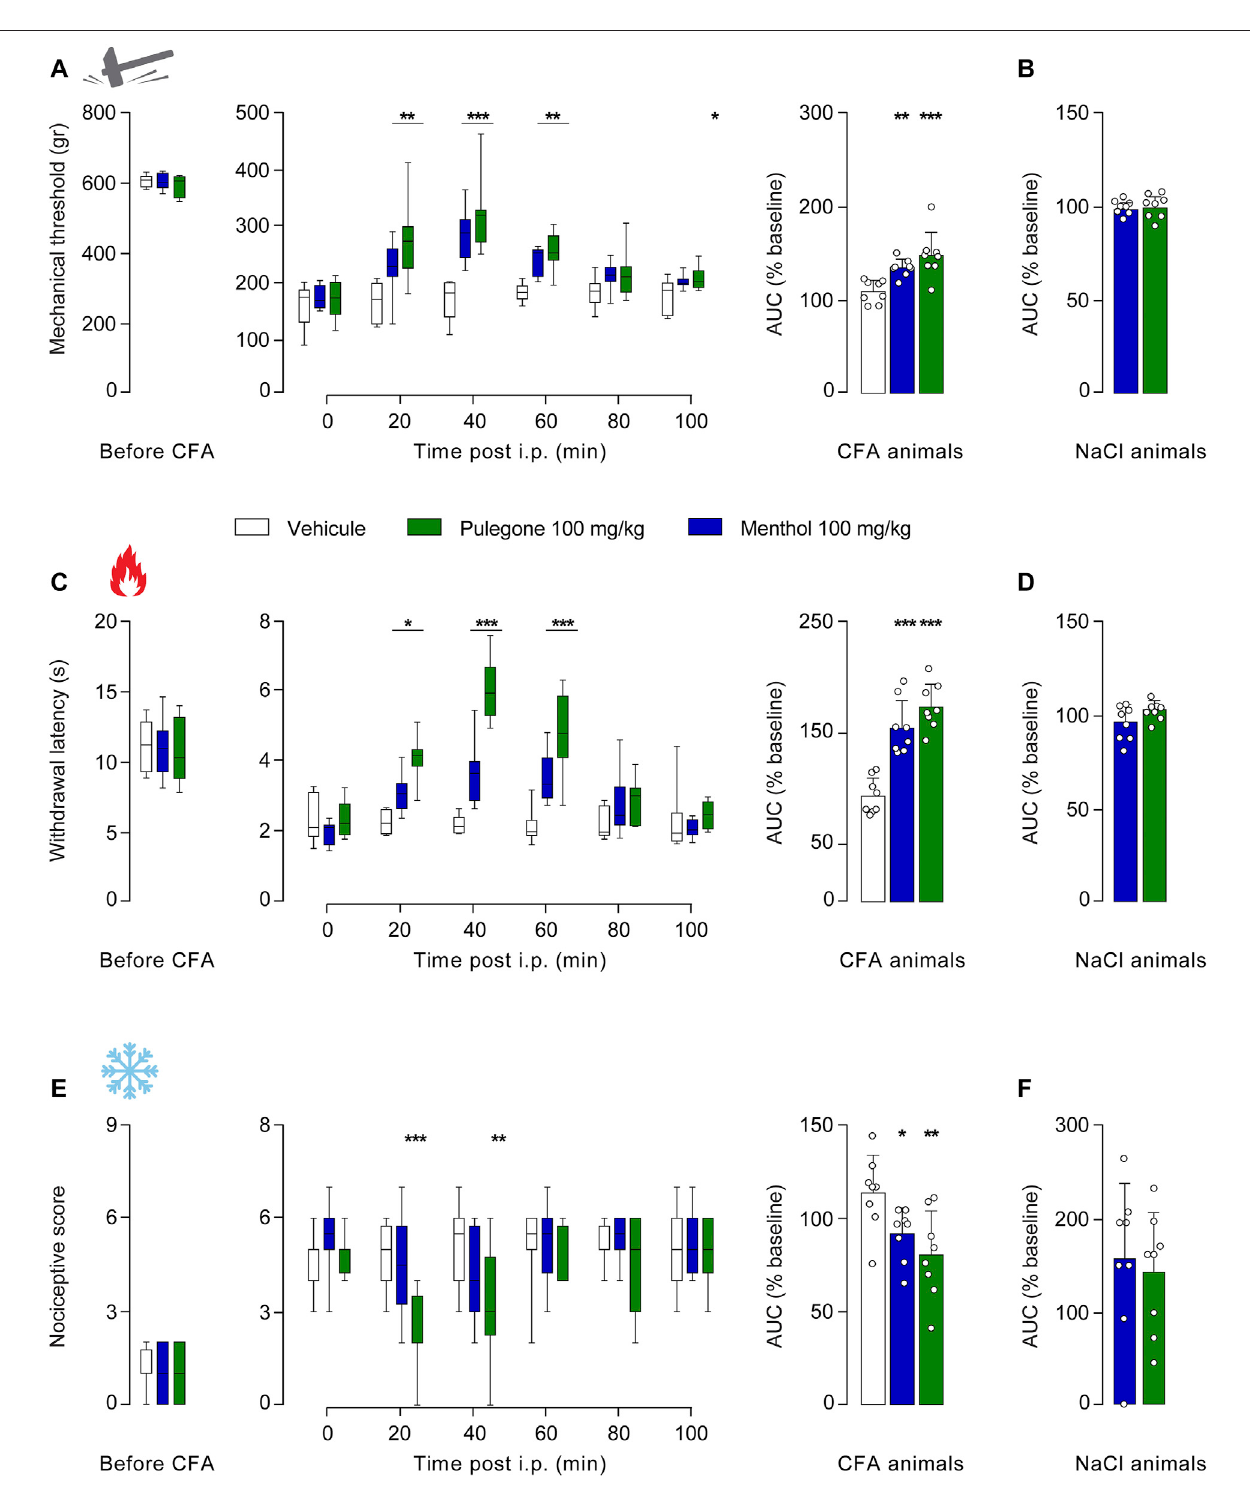
FIGURE 4 | Time-course of the analgesic properties of menthol and pulegone on CFA-induced in fl ammatory pain model. Baseline, time-course, and relative-to- baselineAUC(%)oftheeffectsofi.p.menthol100 mg/kg( n (cid:1) 8),pulegone100 mg/kg( n (cid:1) 8),orthevehicle( n (cid:1) 8)onCFA-inducedmechanical (A) ,thermalheat (C), and thermal cold (E) hyperalgesia. Relative-to-baseline AUC (%) of the effects of i.p. menthol 100 mg/kg ( n (cid:1) 8) and pulegone 100 mg/kg ( n (cid:1) 8) on mechanical (B) , thermal